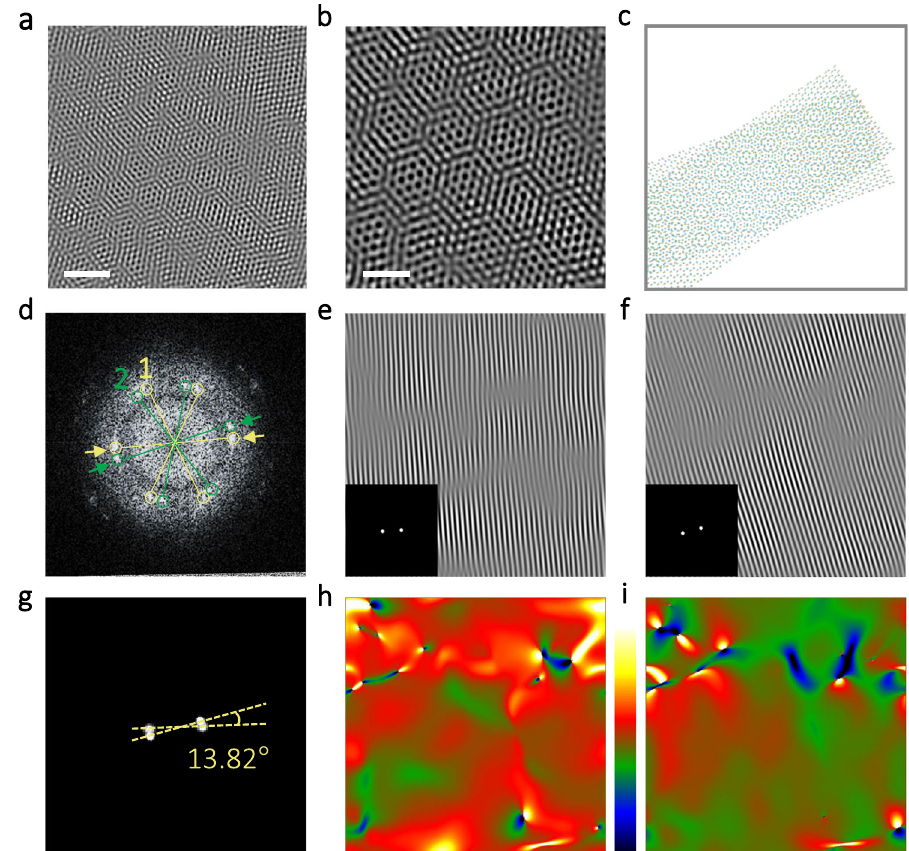
Fig. 2 WS 2 MSLs induced by rotational stacking fault. a High-resolution transmission electron microscopy (HRTEM) characterization of as-prepared WS 2 nanocone. Scale bar, 2 nm. b Enlarged HRTEM characterization. Scale bar, 1 nm. c Schematic diagram of the WS 2 MSLs. Meanwhile, a twist angle of 14° is set in the bilayer regions and distinctive moire ́ patterns are shown clear. Yellow and cyan balls represent S and W atoms. d The corresponding fast Fourier transform (FFT) pattern of ( b ) where the 12 spots constitute two hexagons that are marked with 1 and 2. Hexagon 1 is marked in yellow and hexagon 2 is in green. e , f Corresponding inverse FFT (IFFT) patterns of the FFT spots pointed by the arrows in ( d ). g The fi ltered FFT patterns corresponding to the IFFT patterns of ( e ) and ( f ). h , i Strain distributions of e xx and e xy , respectively. (The color from green to dark blue and the color from red to bright yellow represent the compressive strain and tensile strain,